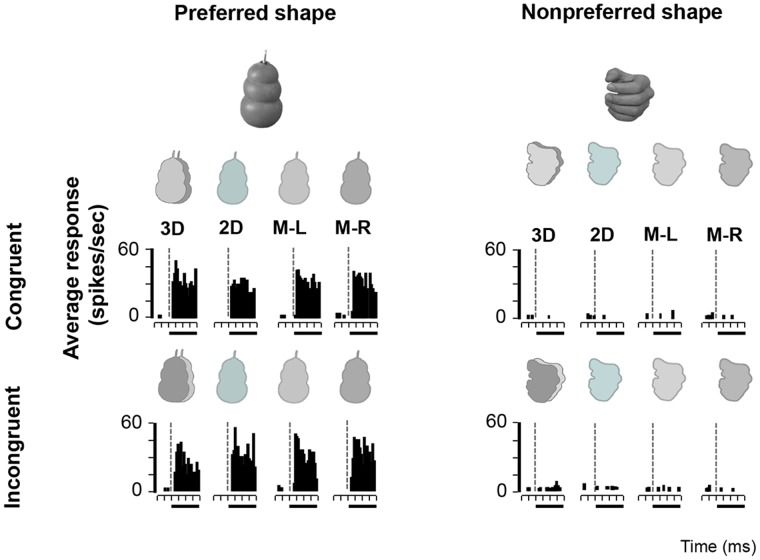
Example neuron not selective for disparity.PSTH of an example neuron that showed significant image selectivity (preferring the image of a kong over the image of a human hand) in the presence and absence of disparity.